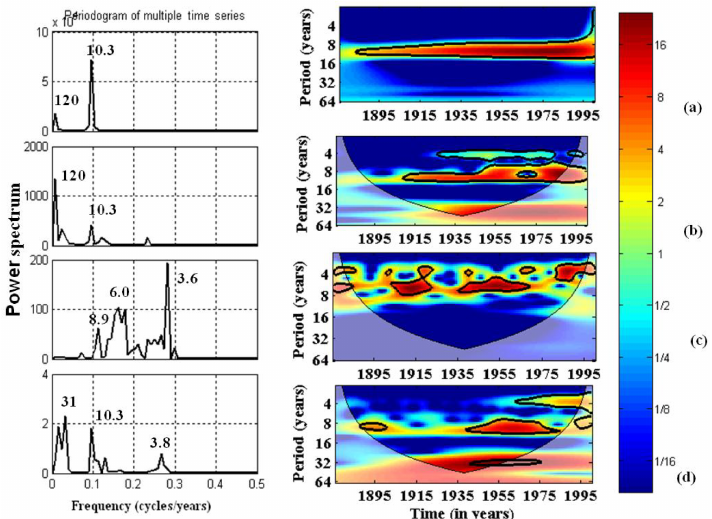
Figure 8. Power spectrum and wavelet power spectrum of SSA reconstructed (a) sunspot data, (b) geomagnetic indices (aa index), (c) SOI, and (d) the Western Himalayan temperature data, with the cone of influence (lighter shaded smooth curve) and black lines indicating sig- nificant power on the 95% level compared to red noise based on the AR(1) coefficient. The legend on the right indicates the cross-wavelet